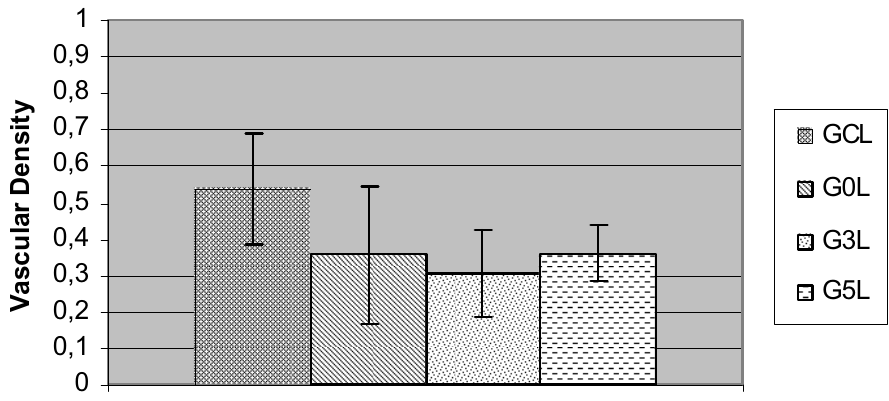
Fig. 1–Comparisonofvasculardensity(mean ± SD)betweencontrolgroupandbevacizumabtreated groups. A significant reduction of vascular density was observed in all treated groups (p < 0 . 05).